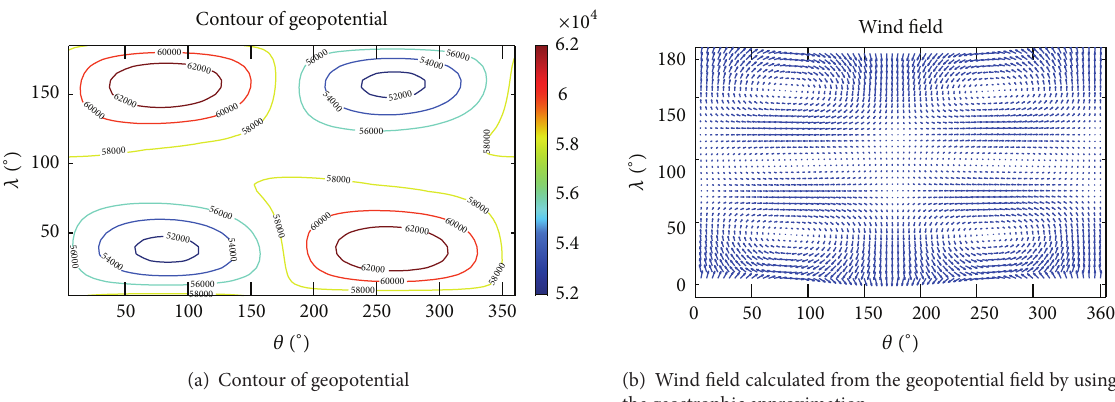
(b) Wind field calculated from the geopotential field by using the geostrophic approximation Figure 2: Contour of geopotential and wind field at 𝑡 = 24 h.